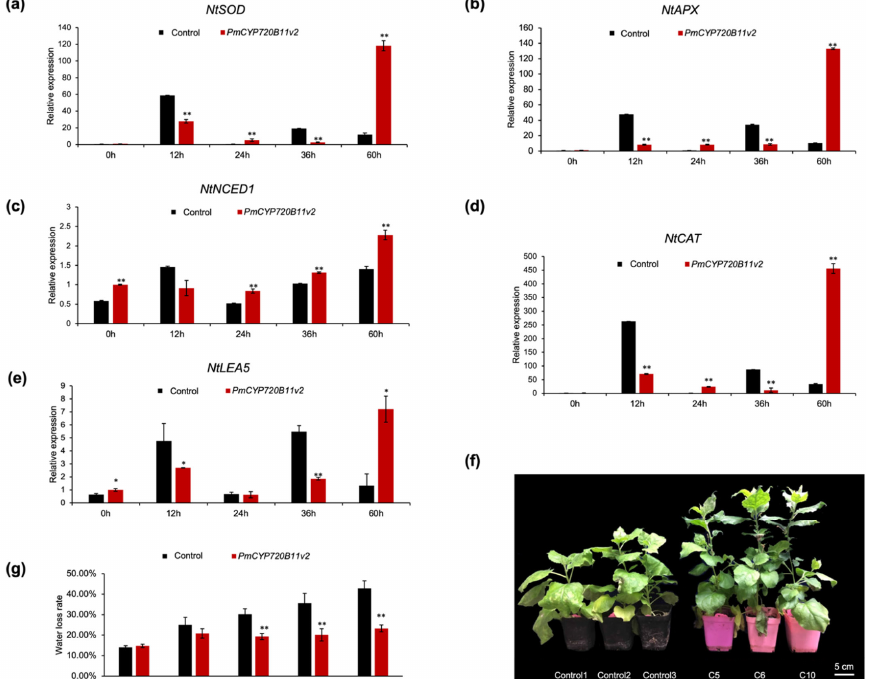
Figure 5. Overexpression of PmCYP720B11v2 enhanced drought tolerance of transgenic tobacco lines. ( a ) Expression level of NtSOD in PmCYP720B11v2 transgenic tobacco under drought stress. ( b ) Expression level of NtAPX in PmCYP720B11v2 transgenic tobacco under drought stress. ( c ) Expression level of NtNCED1 in PmCYP720B11v2 transgenic tobacco under drought stress. ( d ) Expression level of NtCAT in PmCYP720B11v2 transgenic tobacco under drought stress. ( e ) Expression level of NtLEA5 in PmCYP720B11v2 transgenic tobacco under drought stress. Data represent the means ± SEs of three biological replicates. Asterisks indicate statistically significant differences from the control. Confidence levels were tested using Student’s t-tests (*, p < 0.05; **, p < 0.01). The 0, 12, 24, 36, and 60 on the x-axis indicate the time of drought treatment (h), and zero represents the control. ( f ) Different phenotypes in positive transgenic tobacco seedlings overexpressing PmCYP720B11v2 under drought stress; bar, 5 cm. ( g ) Water loss rate of PmCYP720B11v2 -OE lines and control at 0, 12, 24, 36, and 60 h after drought stress